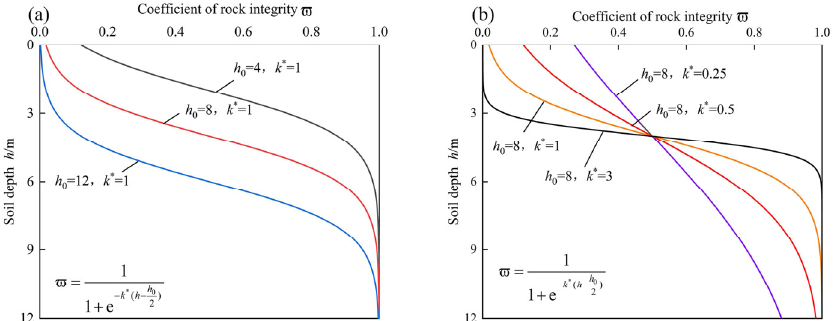
Figure 2. Relationship between the coefficient of rock integrity and depth: ( a ) effect of h 0 ; ( b ) effect of k * .